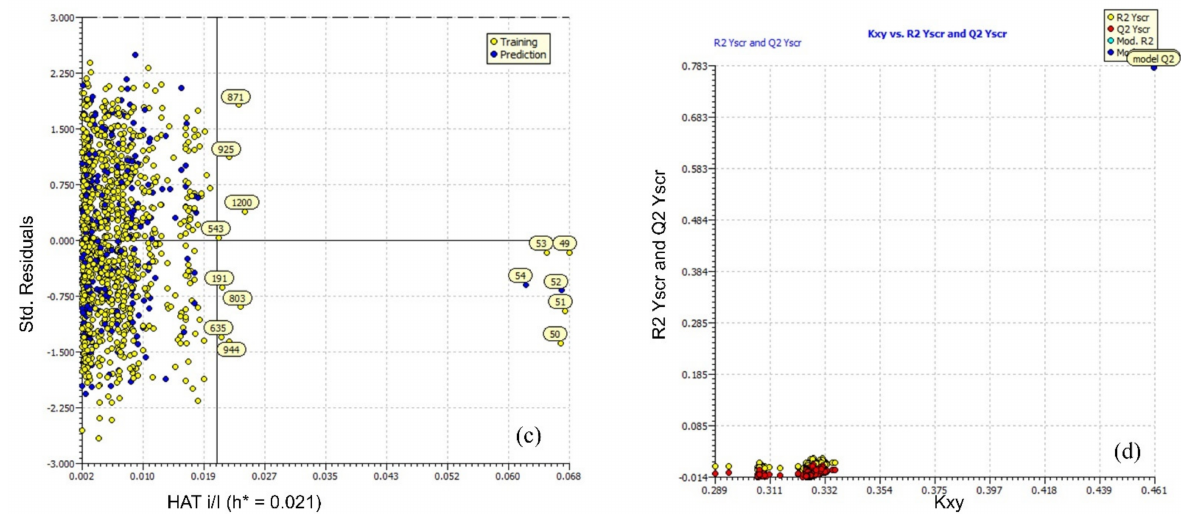
Figure 2. Different graphs associated with the Model-1. ( a ) Experimental vs. predicted pKi (the solid line represents the regression line); ( b ) experimental vs. residuals; ( c ) Williams plot for applicability domain (the vertical solid line represents h* = 0.021 and the horizontal dashed lines represent the upper and lower boundaries of the applicability domain); ( d ) Y-randomization